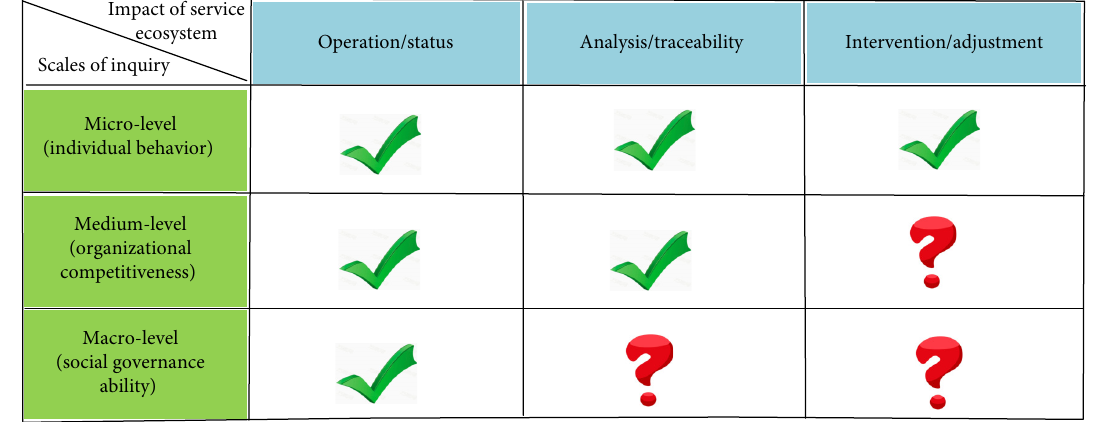
Fig. 11 Research scales of the service